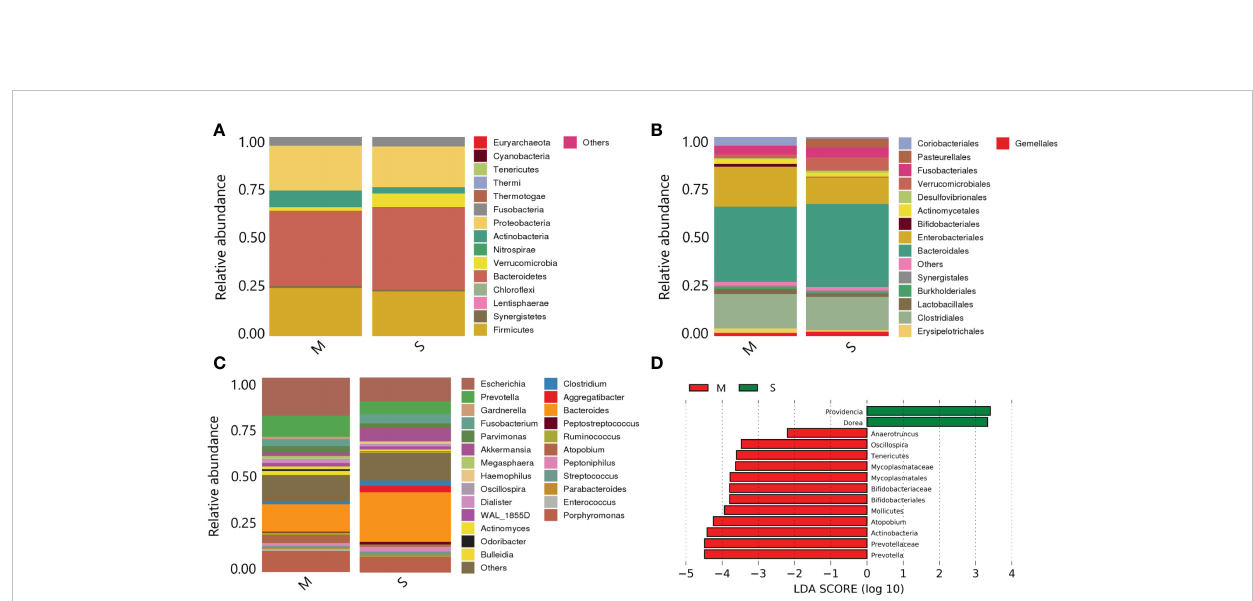
FIGURE 5 Species annotation analysis and composition differences of samples between the two groups. (A) On phylum level; (B) On order level; (C) On family level; (D) Histogram of LDA value